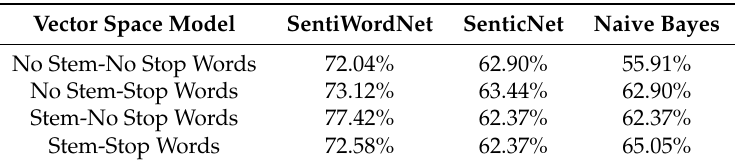
Table 3. Classification rate from SentiWordNet, SenticNet and Naive Bayes techniques for opinion mining: vector space models from the Twitter